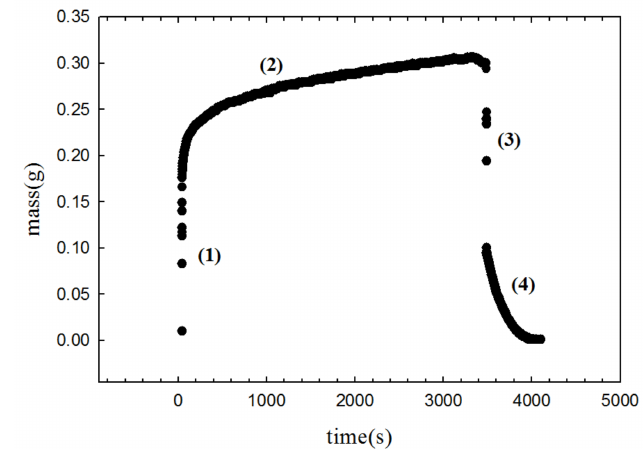
Figure 7. Mass gain approach of the coated wick structure in EtOH; ( 1 ) wetting regime; ( 2 ) wicking regime; ( 3 ) de-wetting regime; and ( 4 ) evaporation regime.